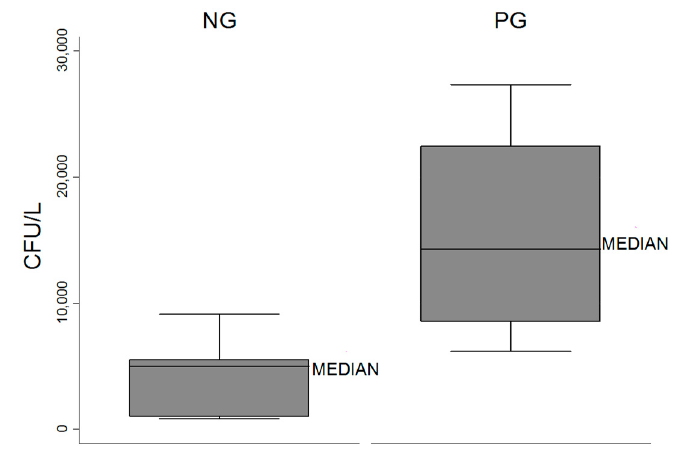
Figure 1. Distribution of daily mean values of Legionella in water of PG 1 and NG 2 . 1 = positive group by at least one of the culture-based methods; 2 = negative group by at least one of the culture-based methods.